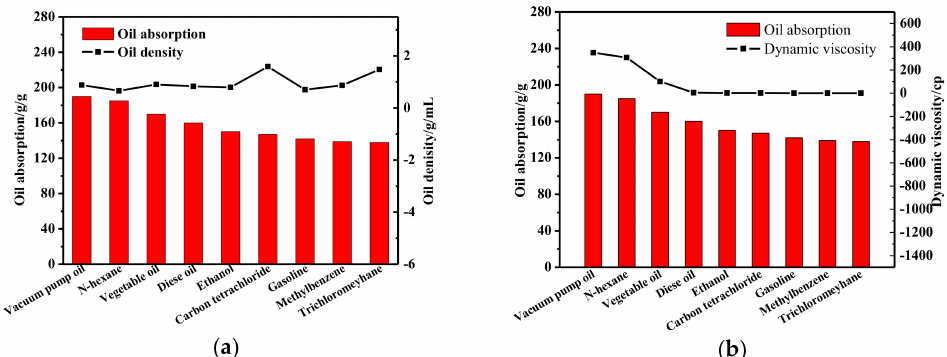
Figure 12. The adsorption capacity of aerogels to oils ( a ) The adsorption capacity of aerogels to oils with different density; ( b ) The adsorption capacity of aerogels to oils with different dynamic